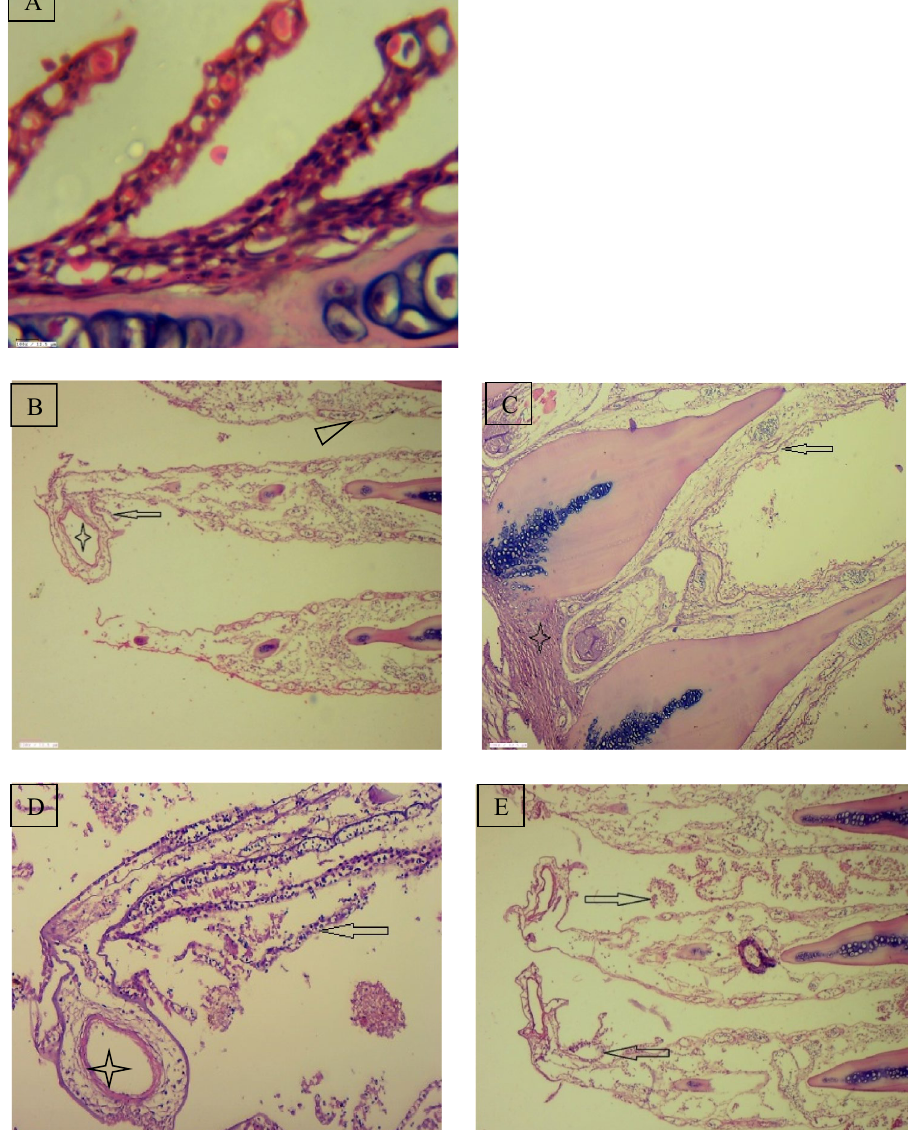
Figure 7. ( A ) Regular shaped secondary gill lamellae in control fish, Gill tissue of Cyprinus carpio (Narora) ( B ) Dilated vessel (star), Sloughing of lamellar epithelium and their disruption (Arrow), Lamellar congestion (Arrow head). ( C ) Disrupted lamellar epithelium (Arrow) and smooth muscle hypertrophy (Star). ( D , E ) Gill tissue of Cyprinus carpio (Rishikesh), Sloughing of lamellar epithelium (Arrow), Dilated vessel (star), Sloughing of lamellar epithelium and their disruption